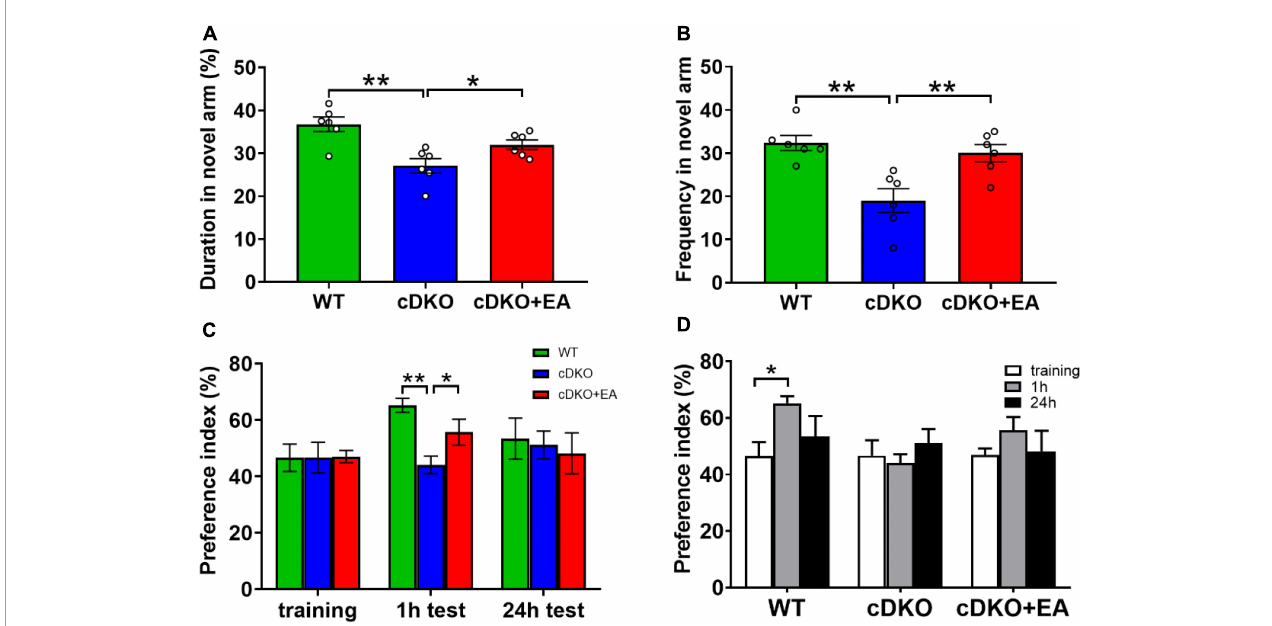
FIGURE1 Electroacupuncture ameliorates cognitive deficits in PS cDKO mice. The duration (A) and frequency (B) of entries in the novel arm of the Y maze. The symbol “ ◦ ” means an individual. (C,D) The preference index in the novel object recognition task. One-way ANOVA, ∗ P < 0.05, ∗∗ P < 0.01, N =